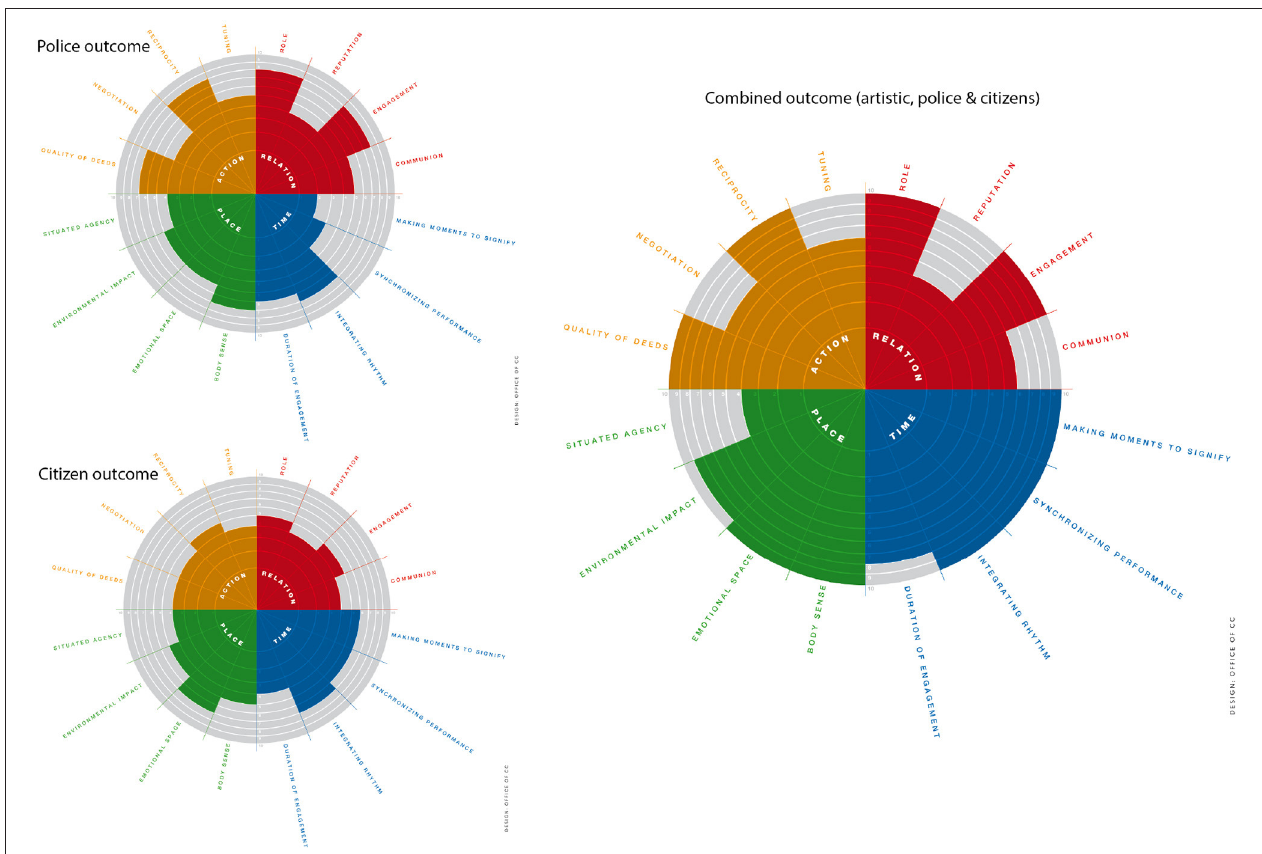
FIGURE 5 | Left part shows the difference between the YUTPA outcomes for citizens and police officers. Right graph is the result of combing all YUTPA analyses to identify possible design spaces. Scores higher than 5 show potential for design.